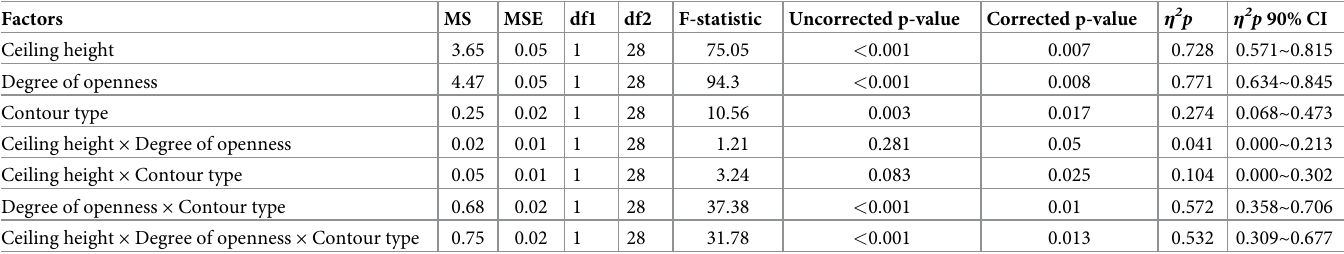
Table 1. ANOVA results for beauty